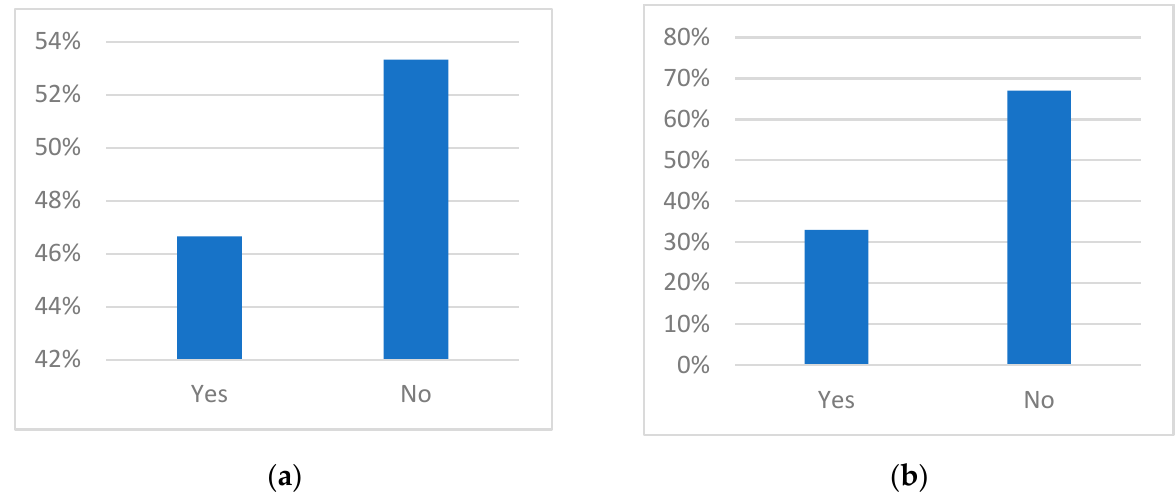
J. Mar. Sci. Eng. 2021 , 9 , x FOR PEER REVIEW Figure 11. Have you experienced a surge in cyber attacks in your organization during the pandemic? ( a ) Europe; ( b ) Asia.